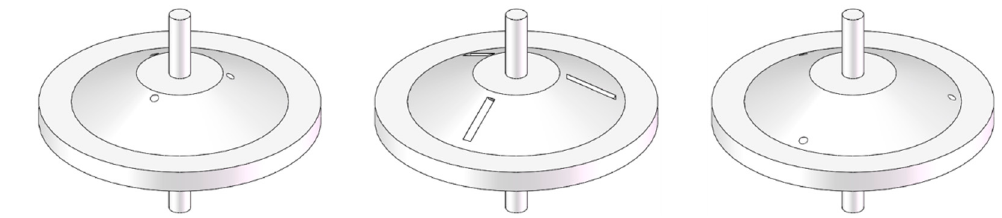
Figure 17. The cymbal transducer with pressure compensation.